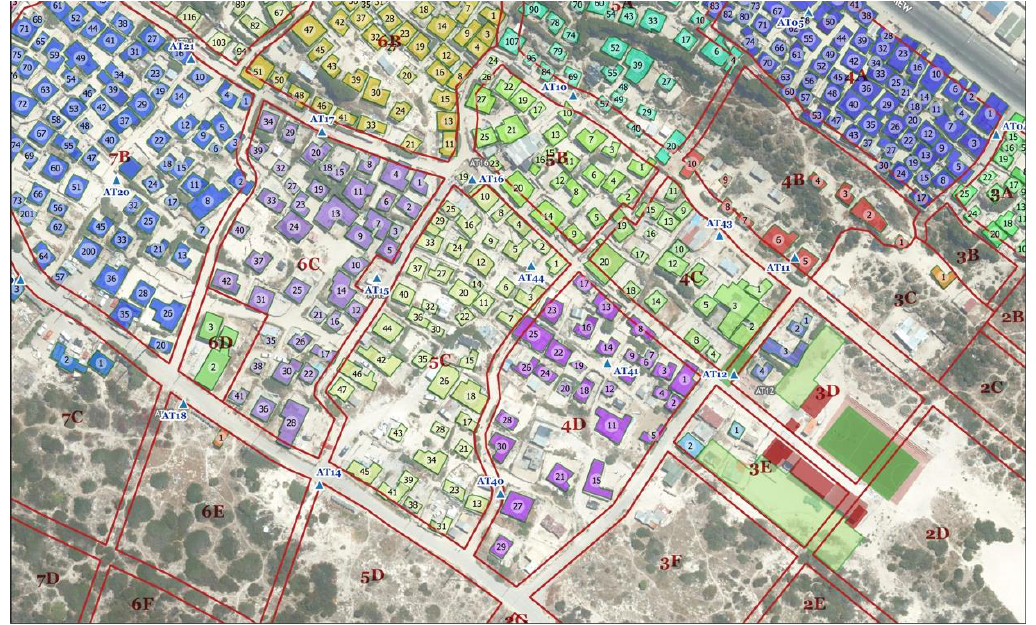
Figure 3. Colour-coded blocks in the Monwabisi Park GIS.